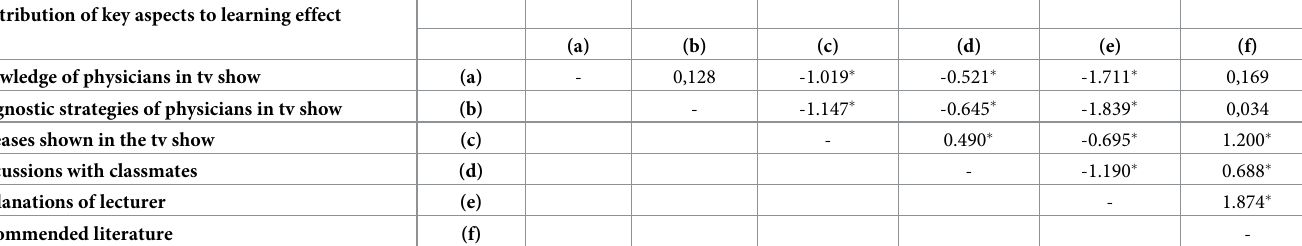
Table 1. Contribution of key aspects to learning